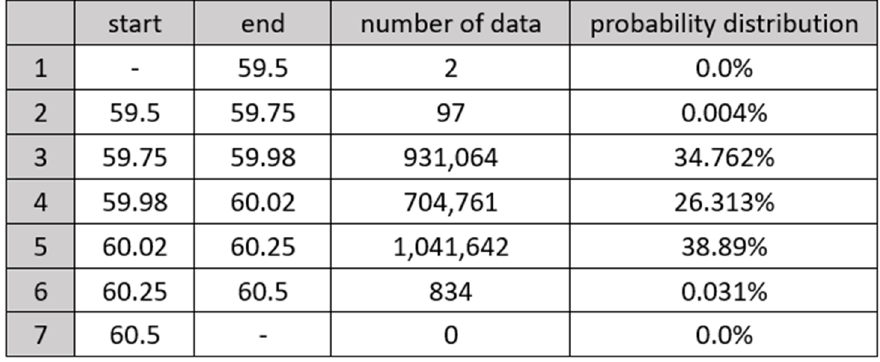
Figure A3. Frequency distribution of December 2019.